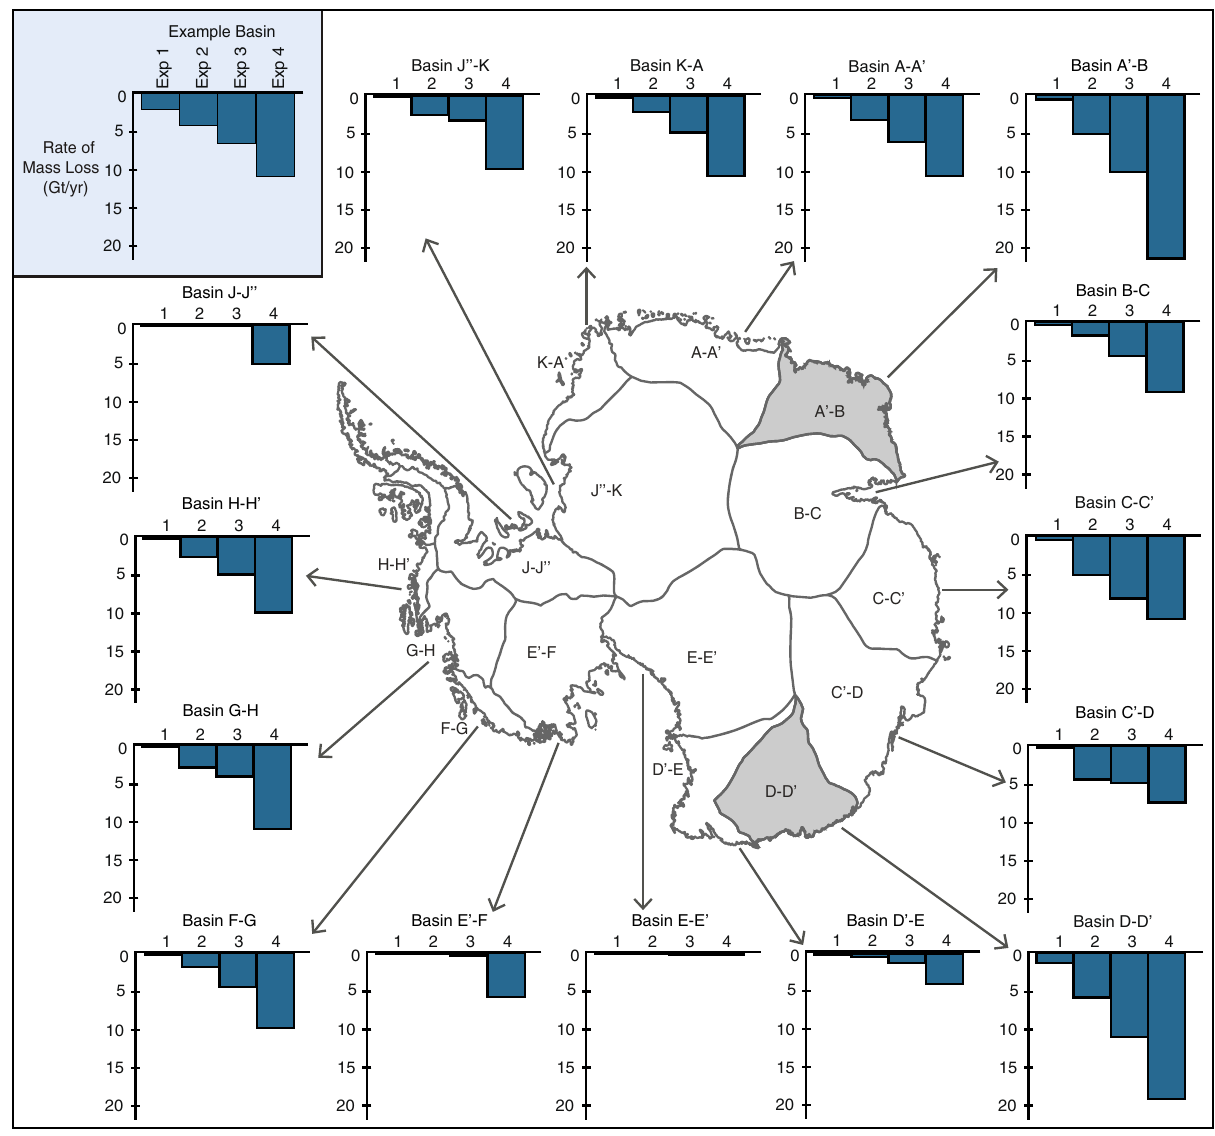
Fig. 4 | Mass loss resulting from 100-year thawing experiments. The bar charts show the change in mass above fl otation relative to the control run for the four